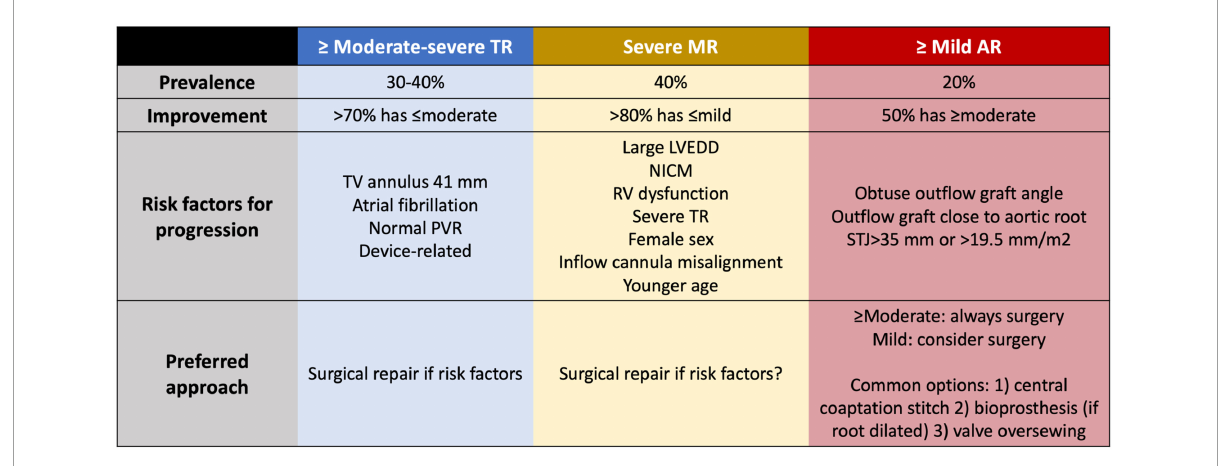
FIGURE5 Prevalence, risk factors for progression and management for valvular regurgitation at the time of LVAD implant to minimize the risk of right ventricular dysfunction. TR, tricuspid regurgitation; MR, mitral regurgitation; AR, aortic regurgitation; TV, tricuspid valve; PVR, pulmonary vascular resistance; LVEDD, left ventricular end-diastolic diameter; NICM, non-ischemic cardiomyopathy; STJ, sinotubular junction.